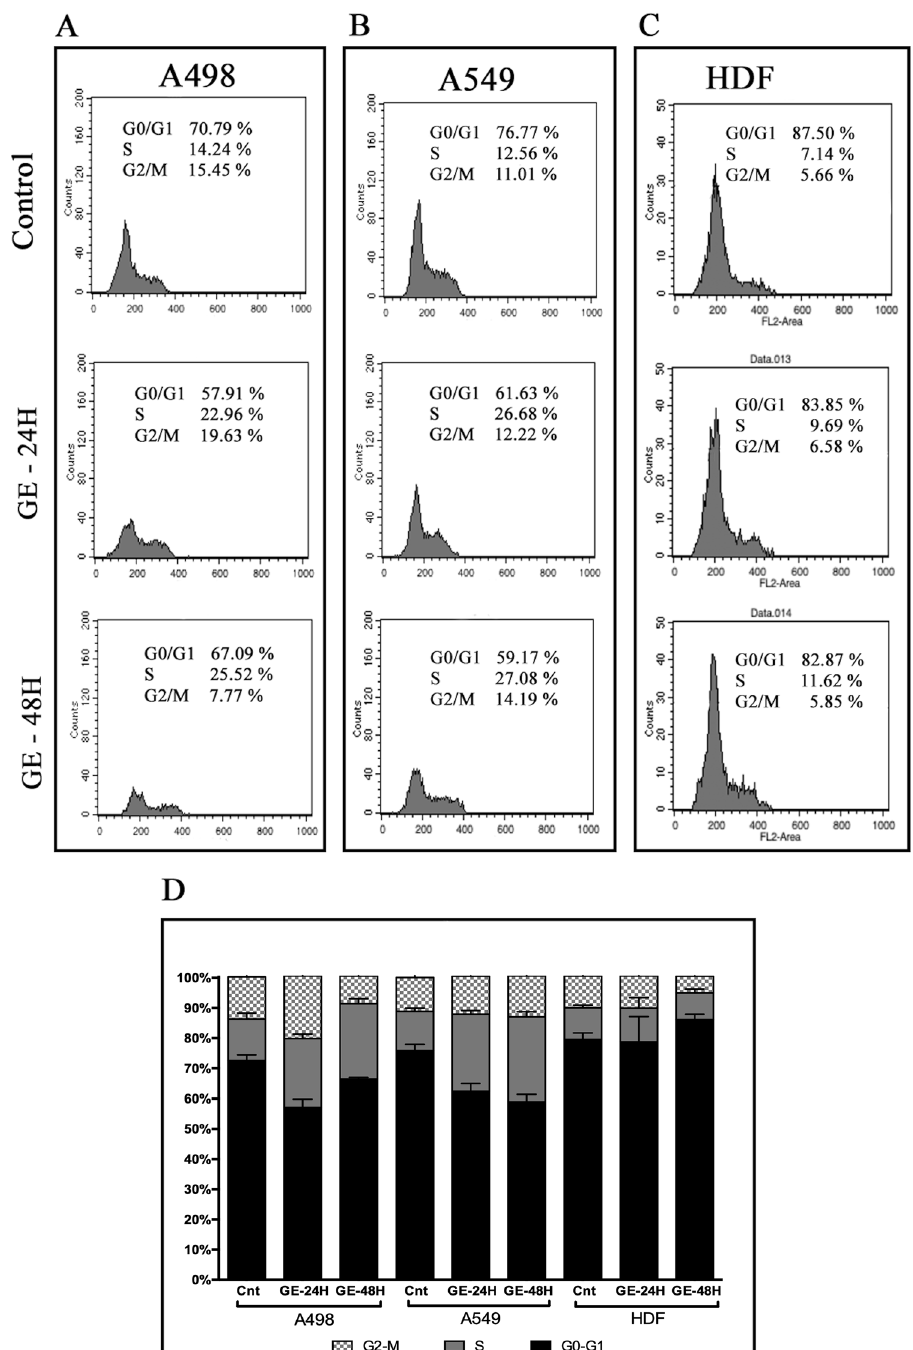
Figure 3. Cell cycle distributions of human kidney carcinoma A-498, human lung carcinoma A-549 and human dermal fibroblast HDF cells ( A ) and their representative bar graph ( B ) after treatments with garlic SEVs for 24 and 48 h. Cells were seeded on 6-well plates and allowed to attach overnight. Cells were treated with 50 µg/ml garlic exosome and incubated for 24 and 48 h and then they were subjected to cell cycle analysis as described in the “Materials and methods” section 50 µg/ml garlic SEVs treated cell populations at G0/G1, S and G2/M phases were analyzed. Data expressed as the mean ±